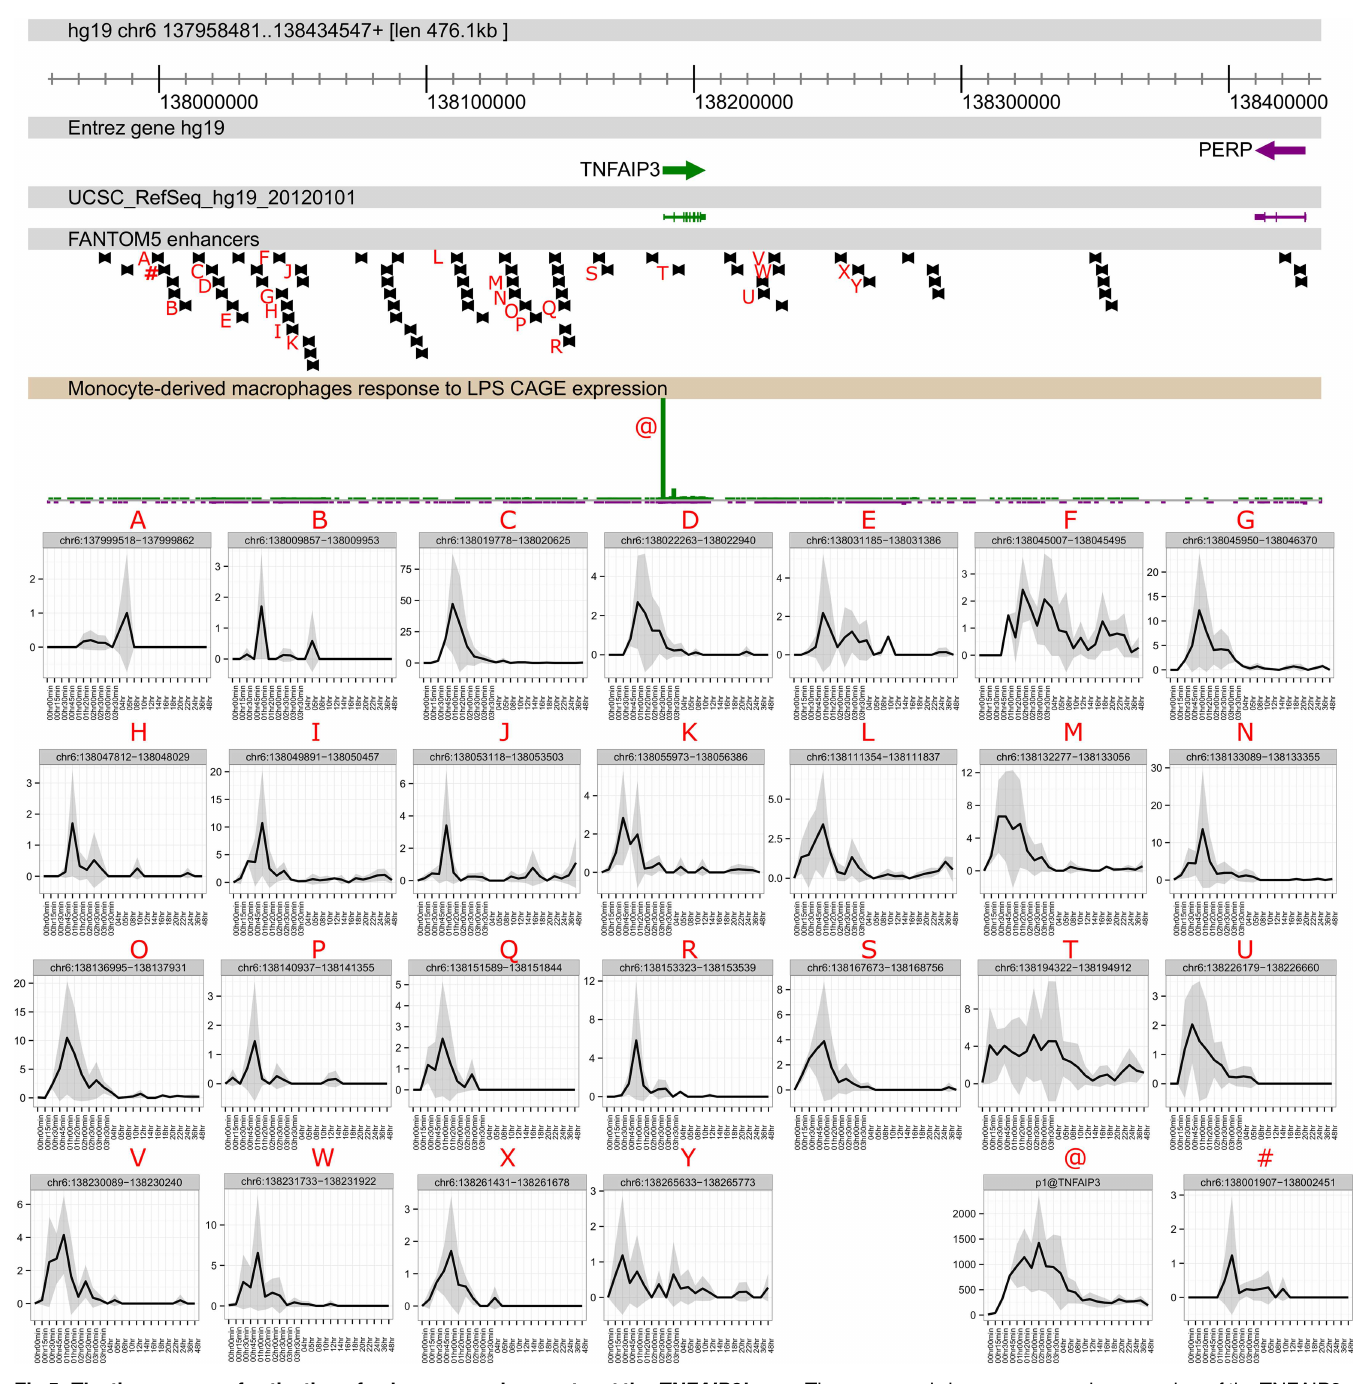
Fig 5. The time course of activation of enhancers and promoter at the TNFAIP3 locus. The core panel shows a genomebrowser view of the TNFAIP3 locus with the locationsof FANTOM5 enhancers. The lower right panel (p1@TNFAIP3) shows the time course of inductionof TNFAIP3 mRNA, detected by CAGE, which peaks around2 hours and declinesto a new, elevated steady state by 8 hours. Other panels show the transient activity of the enhancers indicated, the majority of which peak around1–2 hours and declinerapidly. Panel at bottom right shows the activity of the enhancer containing the SNP originallyassociatedwith CD susceptibility,185kb upstream of the TNFAIP3 locus [2]. Data are expressedas TPM, and are the averageof the three